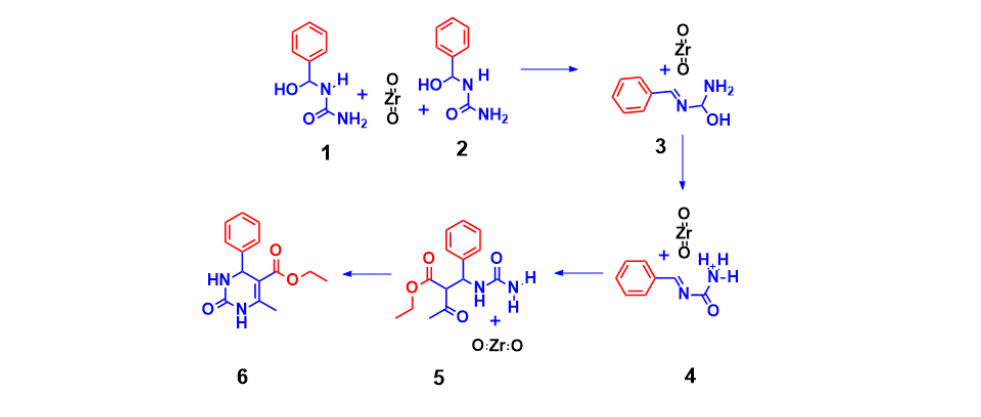
Table 2. Adsorption energy calculations for the Biginelli intermediates and products.